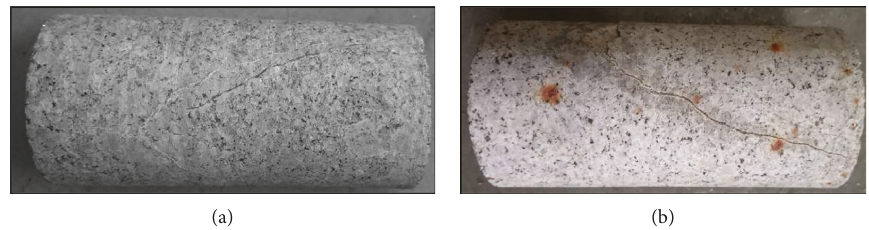
Figure 5: Thermal cracking diagram of granite specimens with the low initial damage. (a) Initial axial compression is 60% of UCS. (b) Initial axial compression is 70% of UCS.